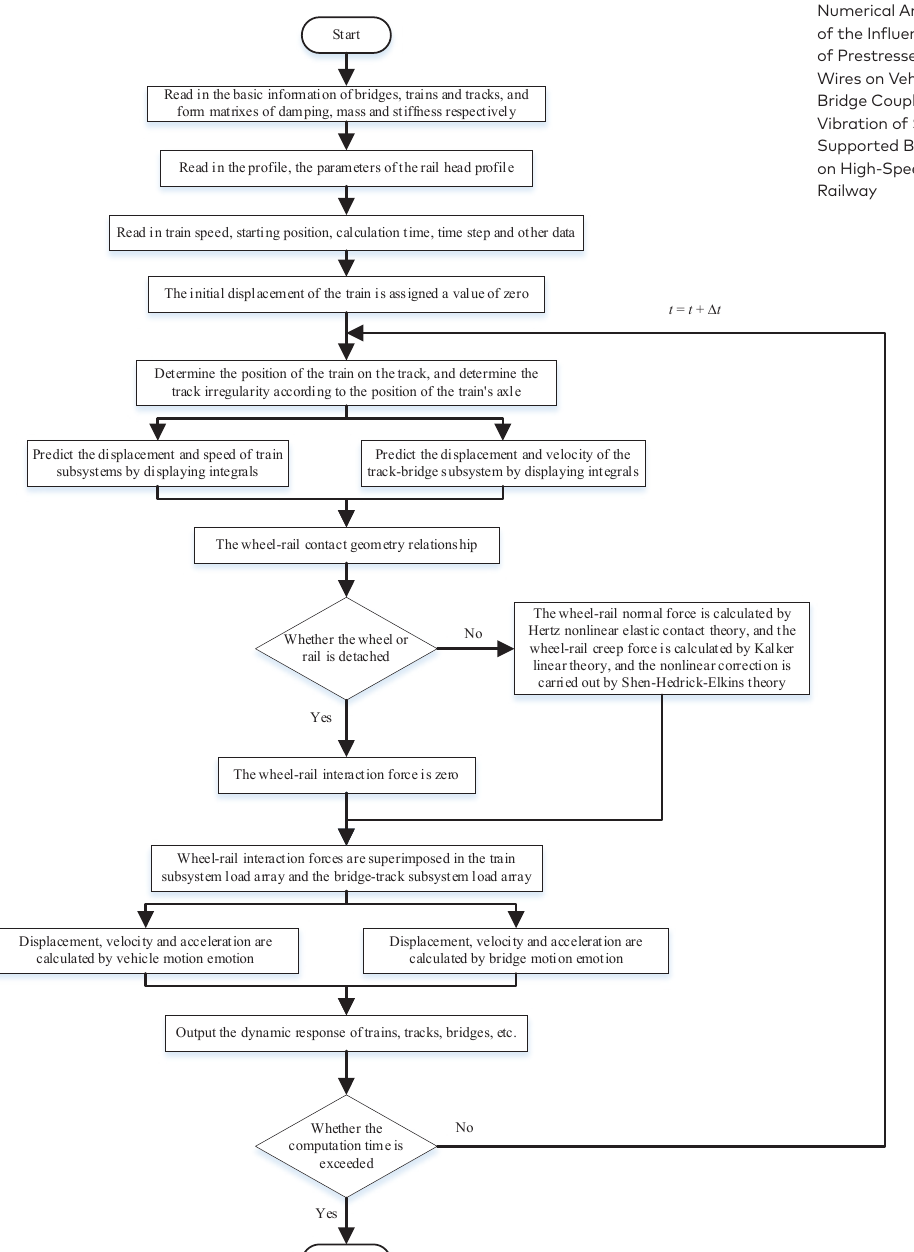
Figure 7. Flow chart of dynamic analysis program